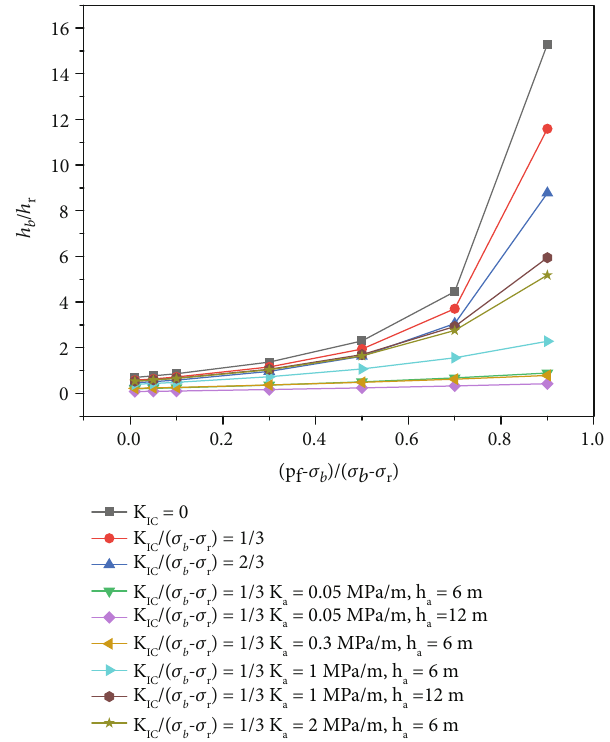
/ h ) under di ff erent conditions ( hr equals to 10m). b r